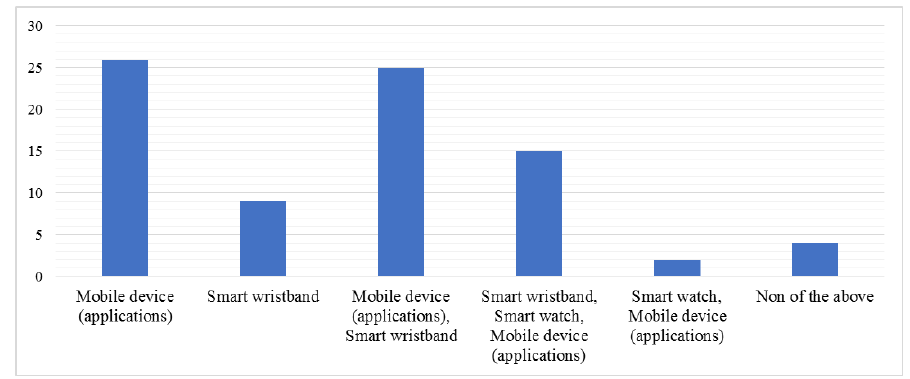
Figure 1 . Possible ways of informing